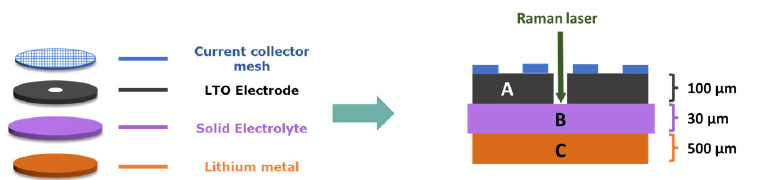
Figure 2. The layers constituting the electrode–aperture system, and the subsequent assembly in this mode with layer thickness shown.